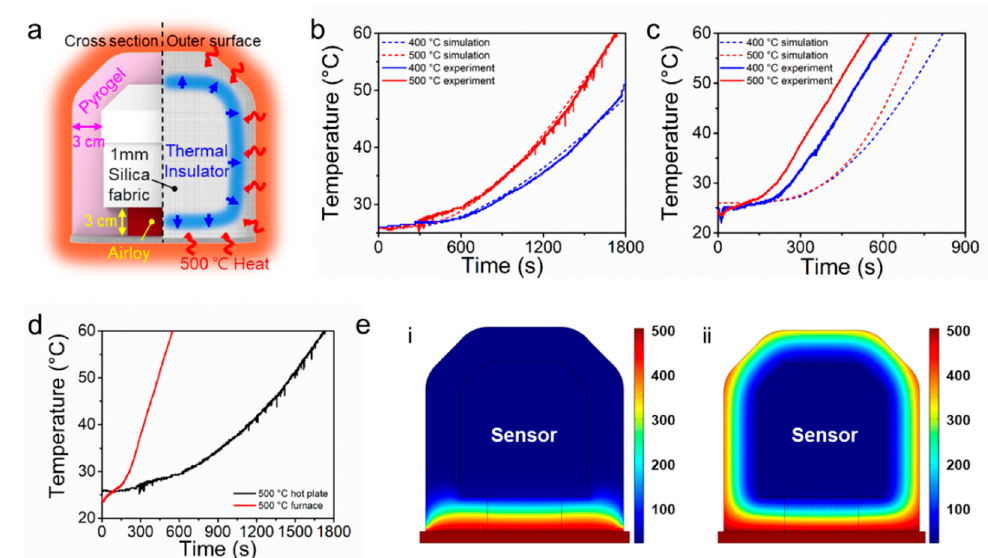
Figure 4. ( a ) Schematic of the insulating materials for thermal protection of SBS; ( b ) Experiment and simulation temperature of the sensor module when only the bottom of an SBS was heated on a 400-°C–500-°C hot plate surface and ( c ) when the entire surfaces were heated by 400-°C–500-°C air and bottom surface in furnace; ( d ) comparison of the experimental results between extreme and minimum conditions at 500 °C; ( e ) cross-section images acquired from the FEA result, showing the temperature distribution when the temperature of the sensor module reaches 60 °C, (i) on a 500-°C hot plate and (ii) in a 500-°C furnace.